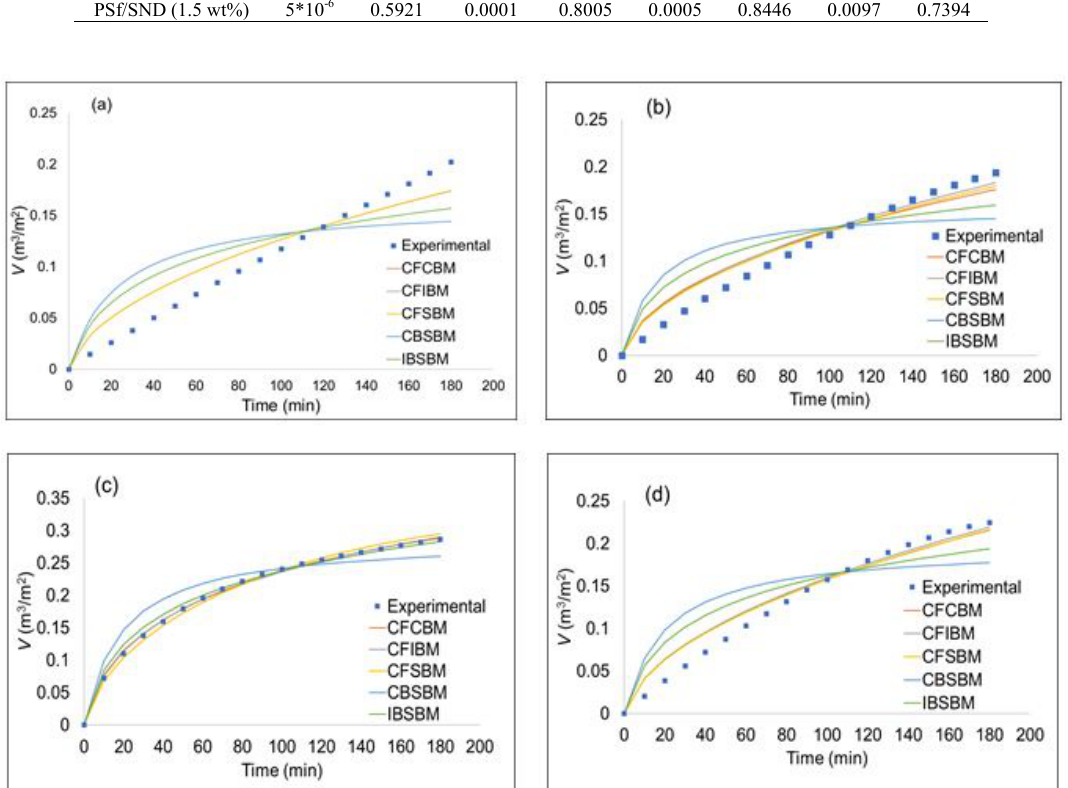
Fig. 8. Experimental filtrated volume data compared to the combined fouling models for (a) PSf, (b) PSf/SND (0.5 wt%), (c) PSf/SND (1.0 wt%), (d) PSf/SND (1.5 wt%) membrane during filtration of HA